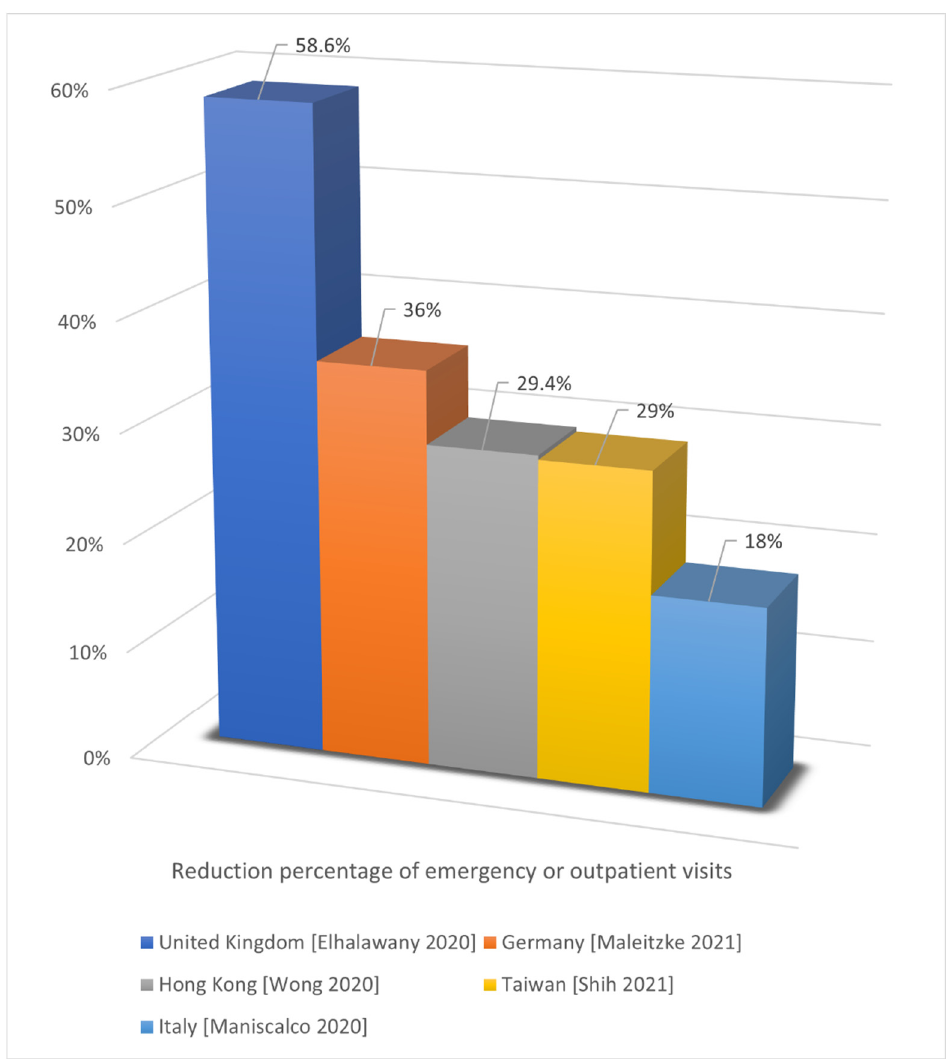
Figure 4. Reduction in emergency or outpatient visits.